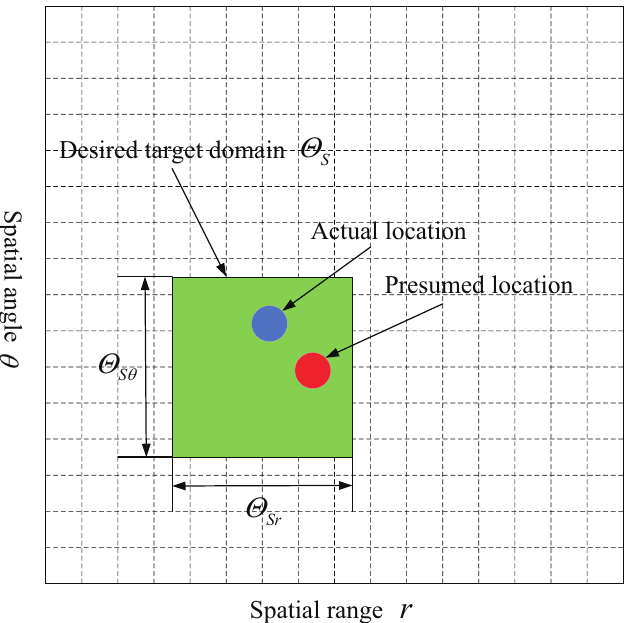
Figure 3. Illustration of Desired target domain in range-angle whole